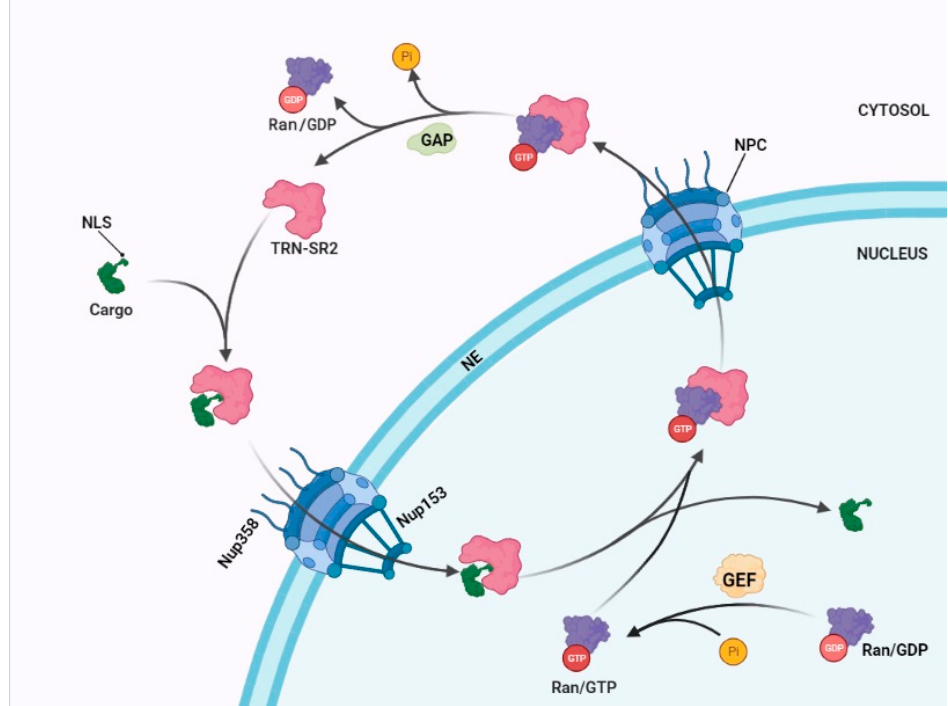
Figure 1. The nuclear transport cycle. In the cytoplasm, cargo/importin complex formation is mediated by the nuclear localization signal (NLS) of the cargo (upper left). In the nucleus the cargo is released upon binding of RanGTP to the importin (lower panel). Next, the importin/RanGTP complex is exported to the cytoplasm where the GTPase activating protein (GAP) hydrolyses GTP to GDP, which subsequently leads to release of importin (upper right). Ran guanine nucleotide exchange factor (GEF) phosphorylates Ran/GDP in the nucleus. The figure is created by https://app.biorender.com (accessed on 22 March2021).